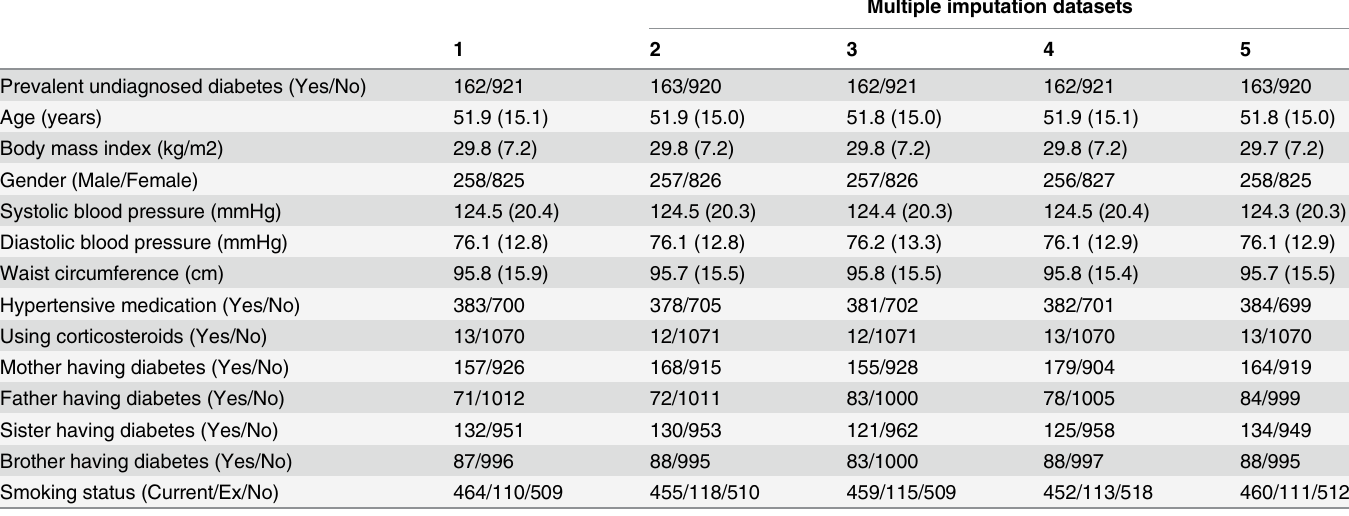
Table 4. Characteristics comparison of participants for five multiple imputation